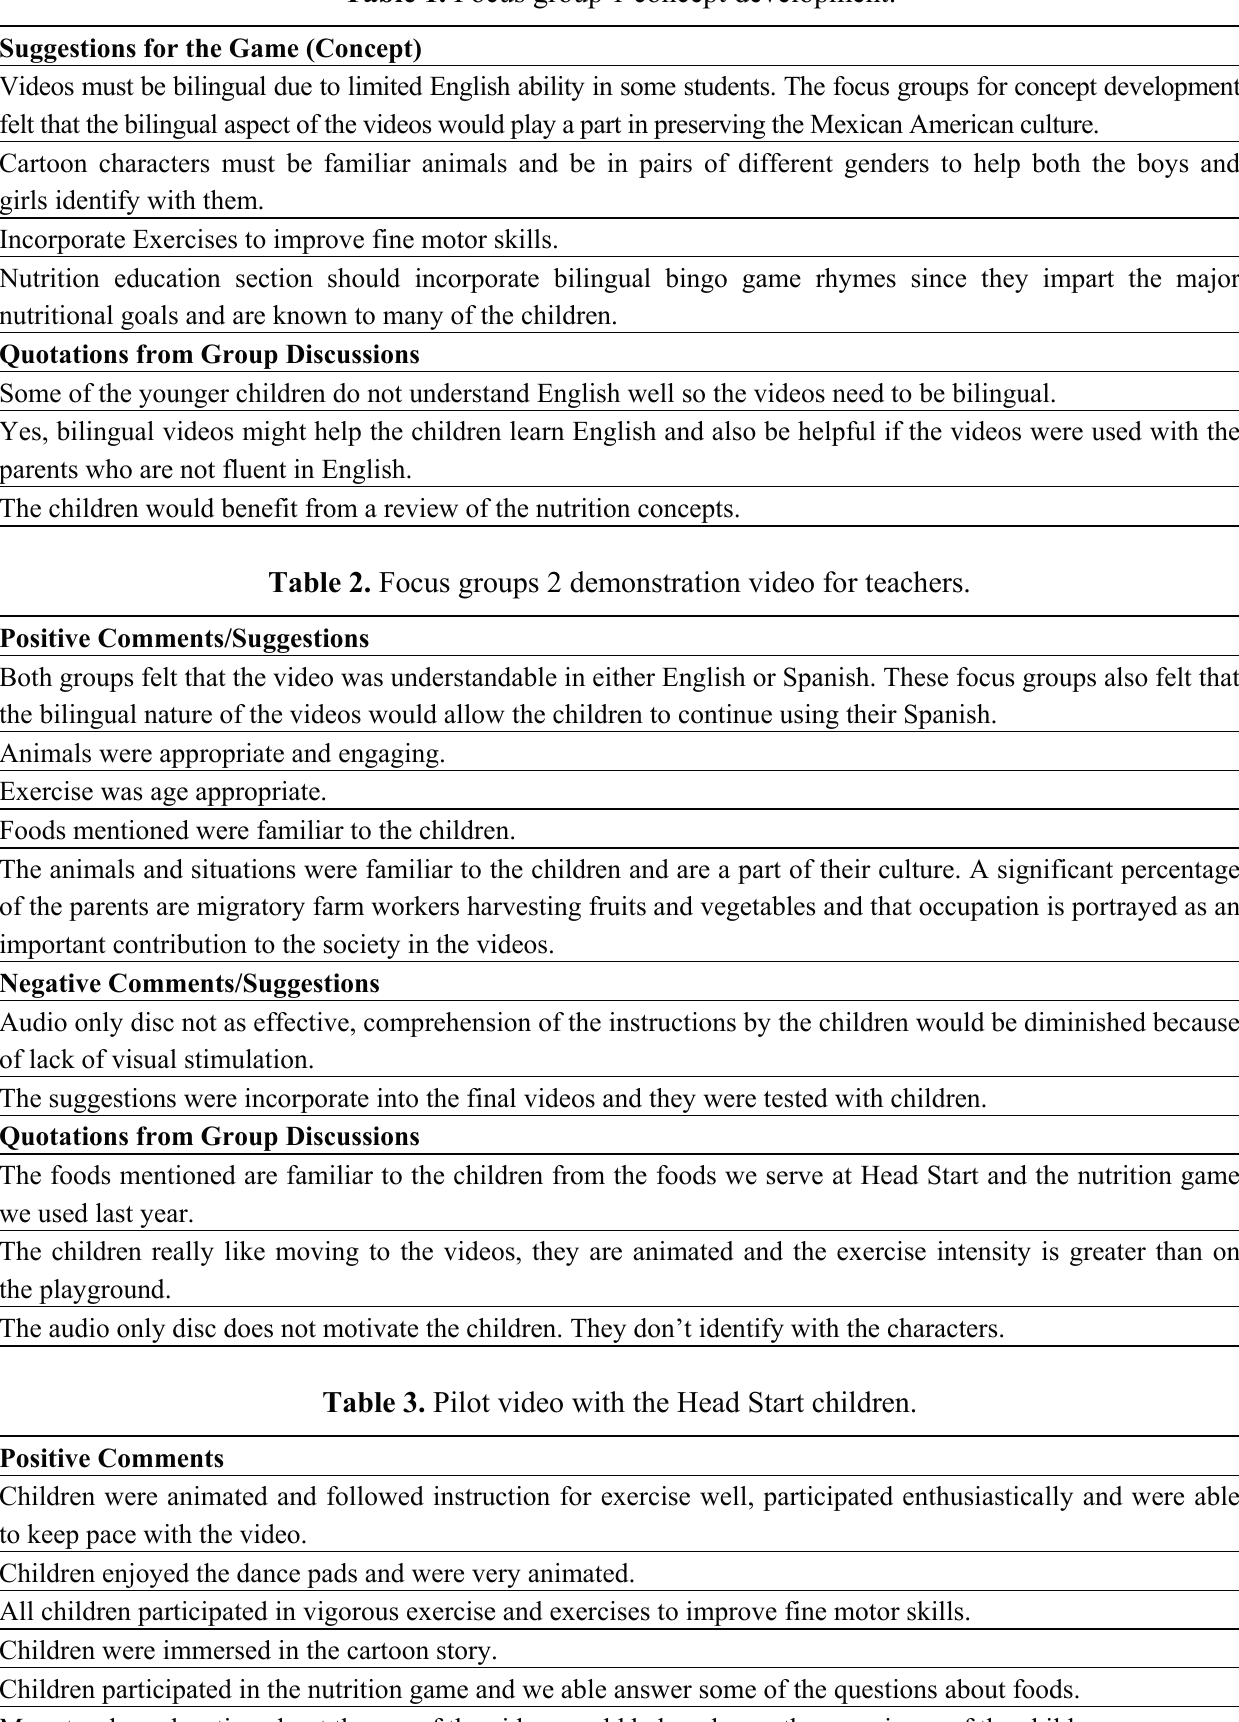
Table 1. Focus group 1 concept development.